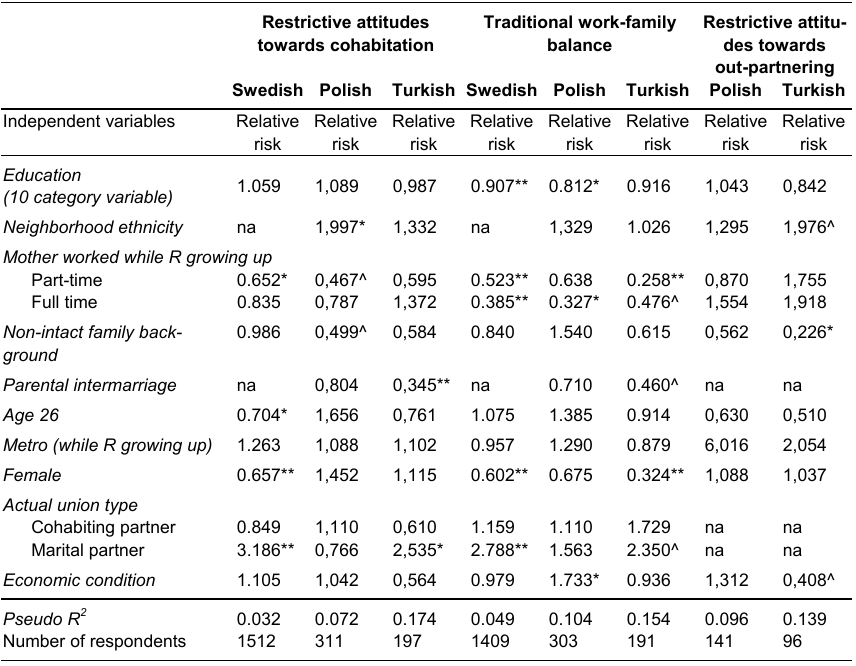
Table 6. Multivariate analysis of attitudes toward family forms (odds ratios) Restrictive attitudes Traditional work-family Restrictive attitu- towards cohabitation balance des towards out-partnering Swedish Polish Turkish Swedish Polish Turkish Polish